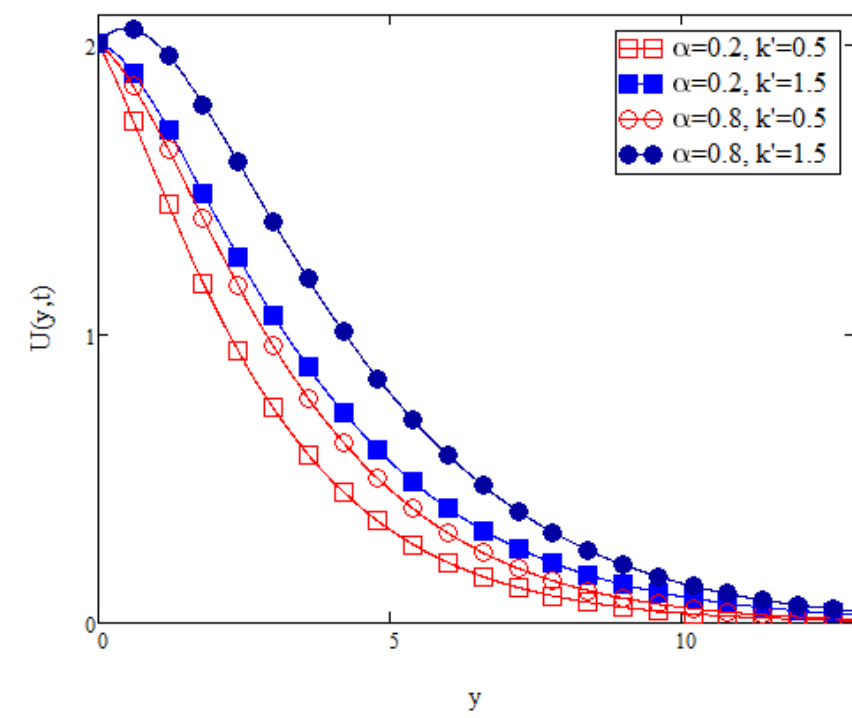
Figure 13. Variation in velocity profile due to variations in k’ and α